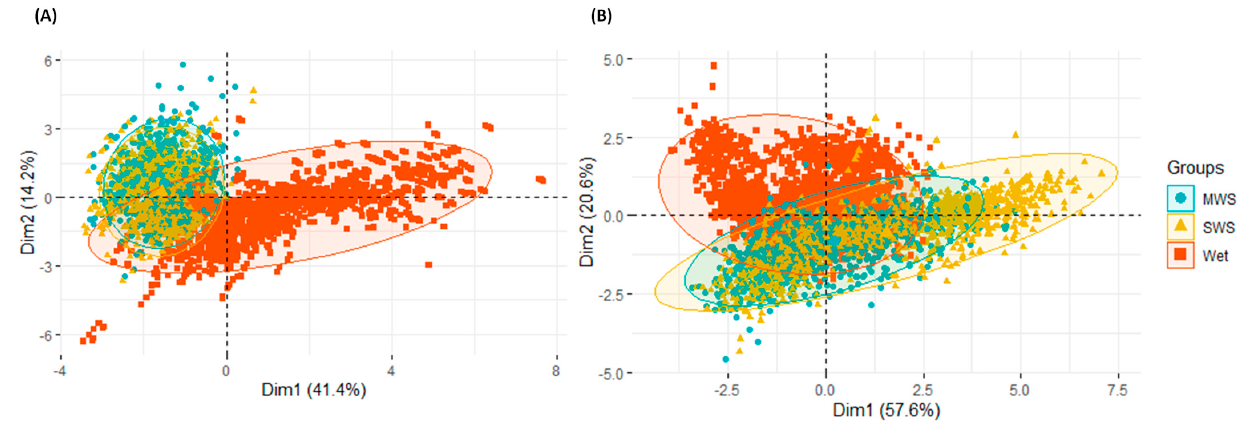
Figure 1. Principal component analysis of the genotypes grouped by: ( A ) agronomic traits and ( B ) feed quality traits, using pooled data from all harvests. Genotypes are grouped according to if they were grown under moderate water stress (MWS) (blue color), severe water stress (SWS) (yellow color) or rainy season (wet) (red color) conditions.